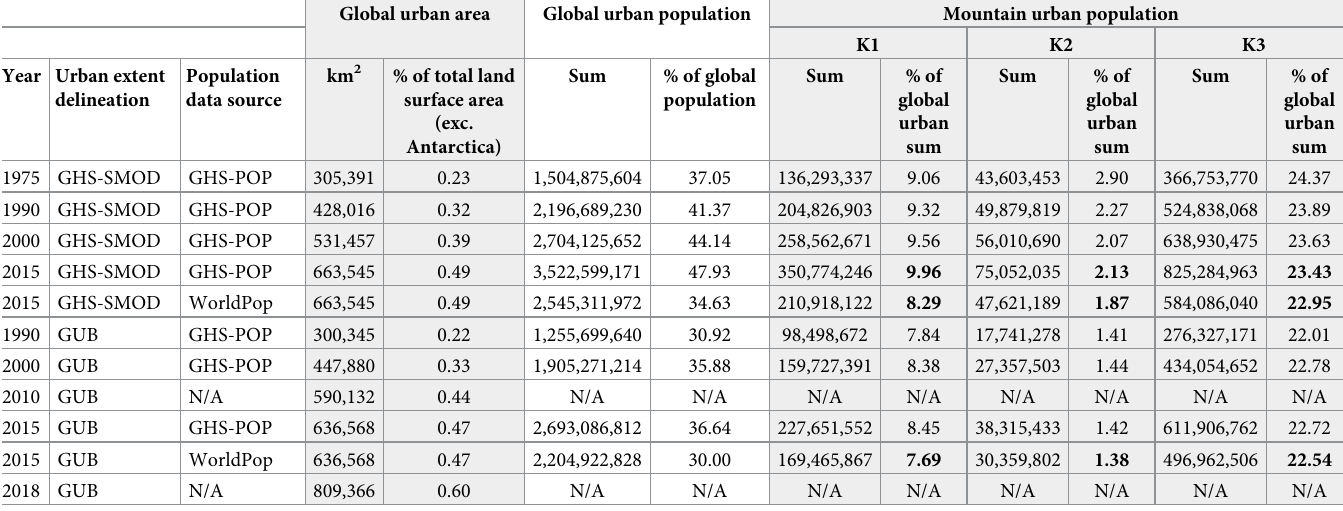
Table 1. Summary of global total and mountain-only urban population estimates according to GHS-POP and (for 2015) WorldPop population datasets for alterna- tive combinations of urban and mountain extent